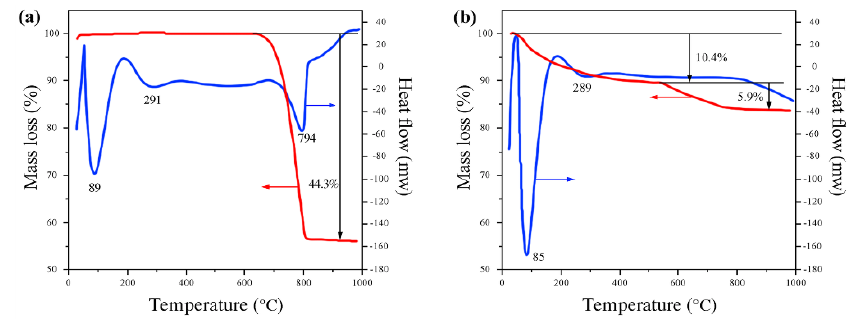
Figure 3. TG/DSC curves of ( a ) CaCO 3 and ( b ) TiO 2 ∙ nH 2 O. Figure 3. TG / DSC curves of ( a ) CaCO 3 and ( b ) TiO 2 · nH 2